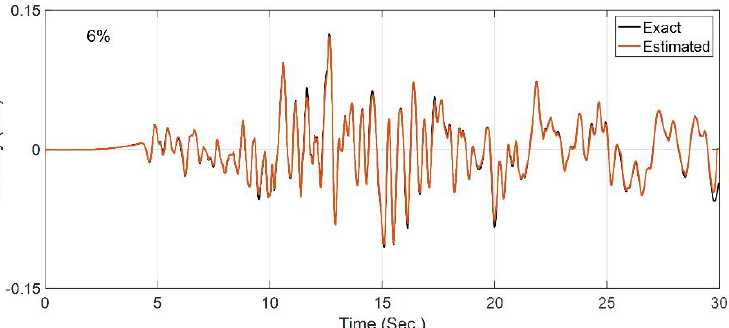
Figure 14. Comparison between the true incident motion and the estimated incident motion in Case Study